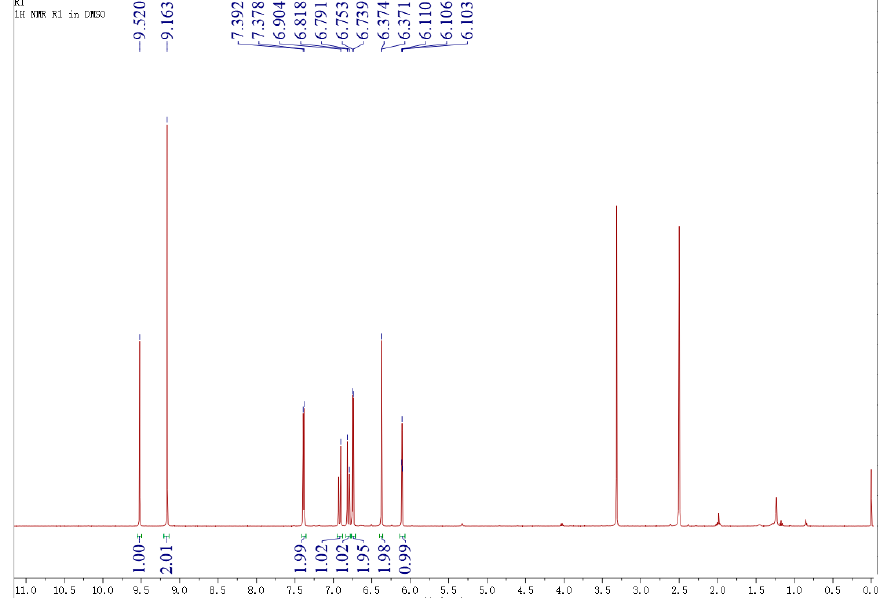
Figure 4. Nuclear magnetic resonance ( 1 H-NMR) spectrum of purified resveratrol by X1.